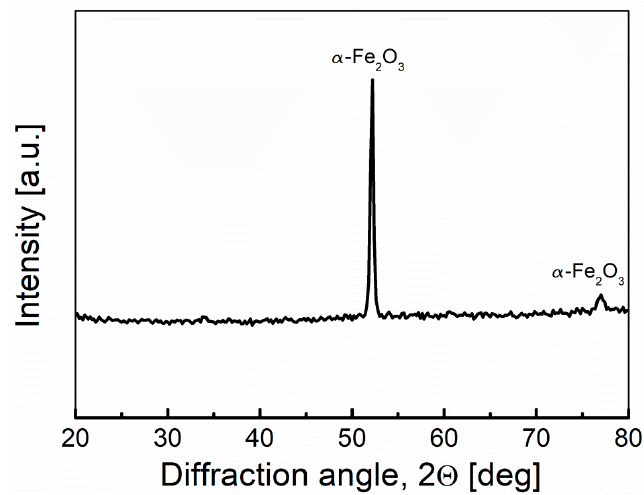
Figure 15. XRD pattern recorded for the electrolyte container surface—cathode of Model I MH-DCFC.